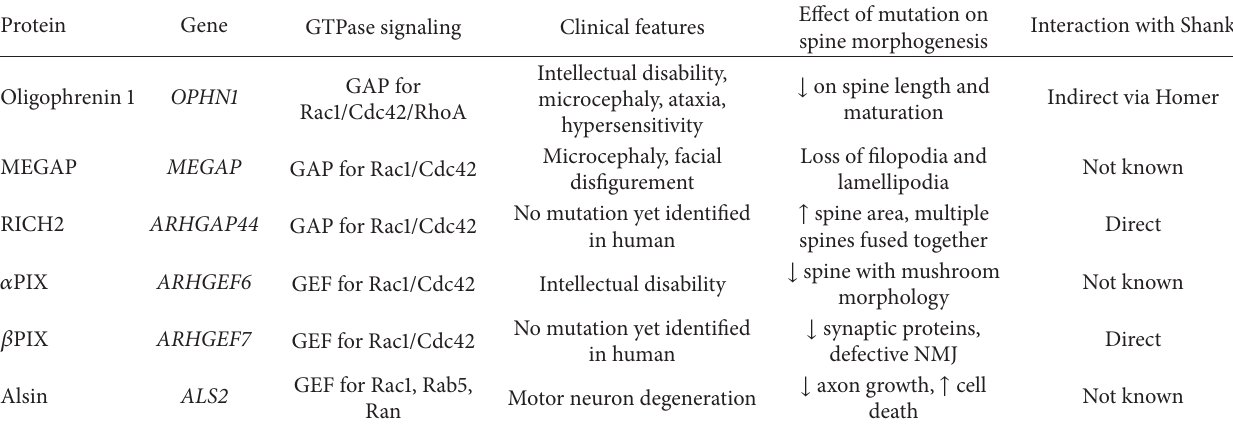
Table 1: Rho GTPase modulators in mental